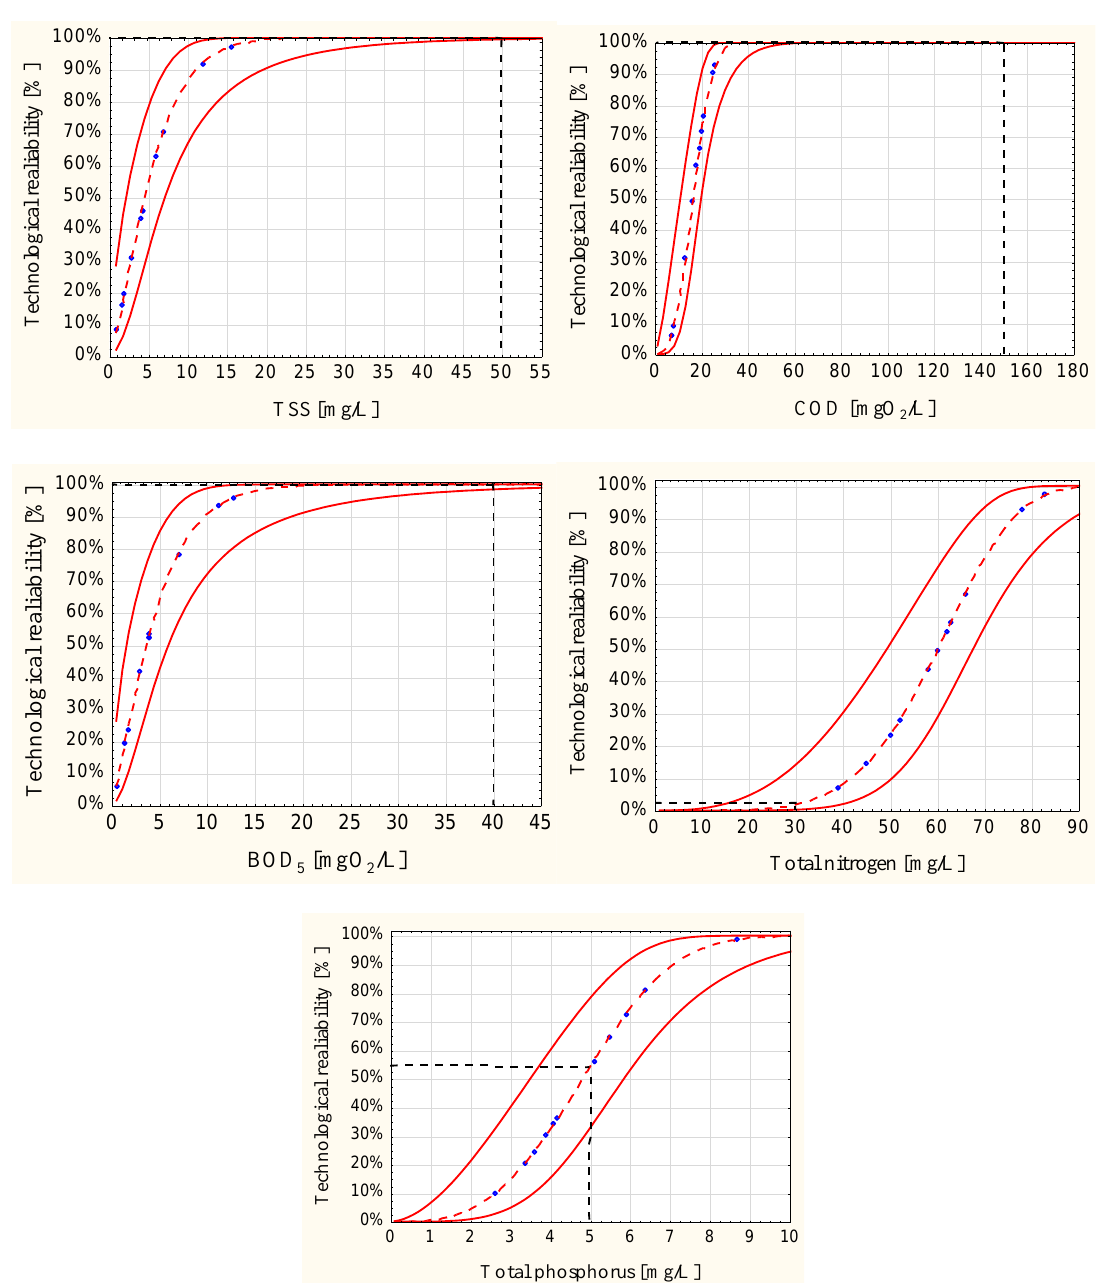
Figure 7. Weibull cumulative distribution functions and the technological reliabilities determined for each pollution parameter. Notation: dashed red line—reliability function, dashed black line—probability of achieving the indicators limit in the effluent.